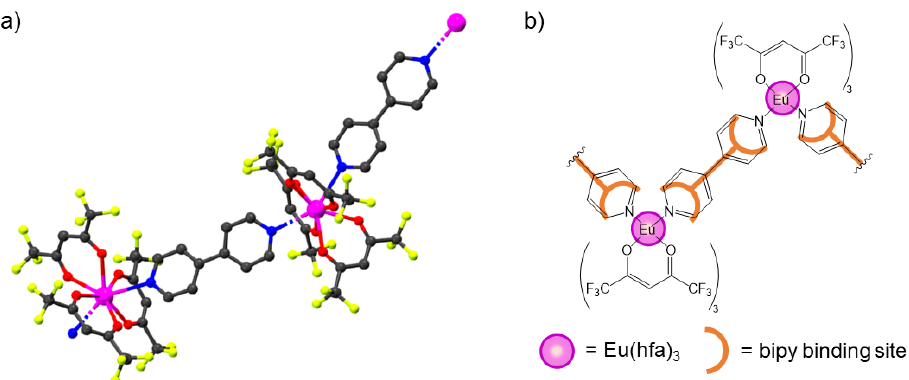
Figure 1. ( a ) Structure of a portion of the chain of [Eu(hfac) 3 (bipy) ∙ toluene] n . Toluene molecules were omitted for clarity. CCDC number 1471967, from ref. [33]. ( b ) Schematic representation of [Eu(hfac) 3 (bipy) ∙ toluene] n